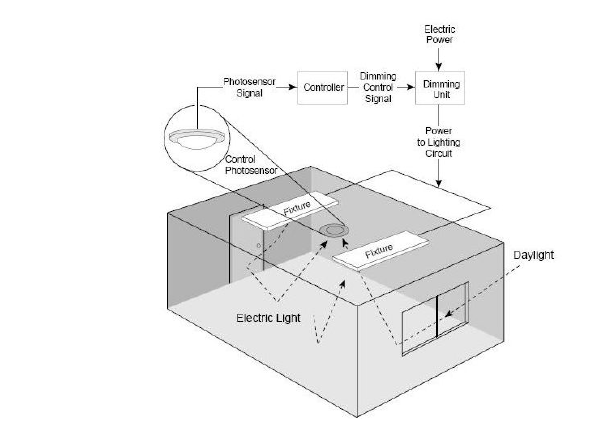
Figure 1. Geometry Buildings